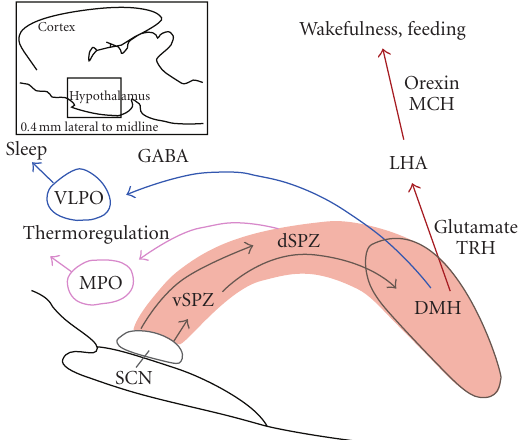
Figure 1: The interaction between circadian (C) and homeostatic (S) processes in an “opponent-process” results in an uninterrupted 8-hour nocturnal sleep episode and a wake period maintained throughout the 16-hour day. The homeostatic drive for sleep (illustrated as the “sleep load”) increases throughout the waking period and reaches a peak just before habitual bedtime. The circadian drive for alertness (illustrated as the “alerting signal”) reaches a peak at this time and is lowest near the end of the sleep episode. From [8].